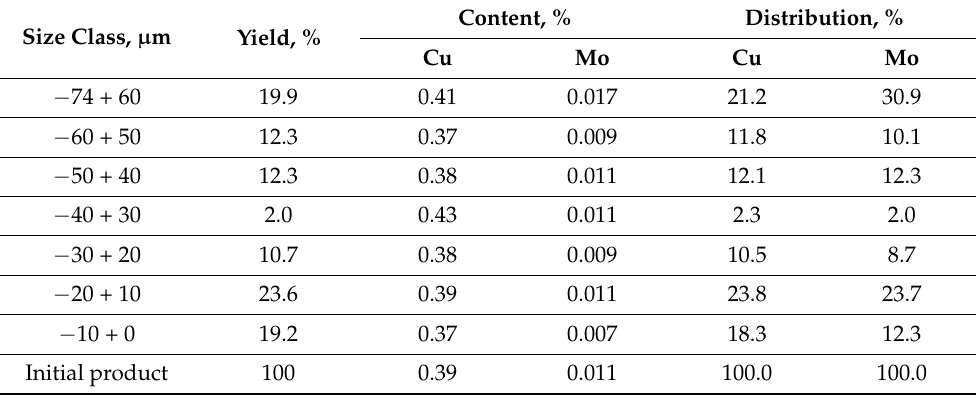
Table 2. Granulometric composition of crushedCu-Mo polymetallic ore.